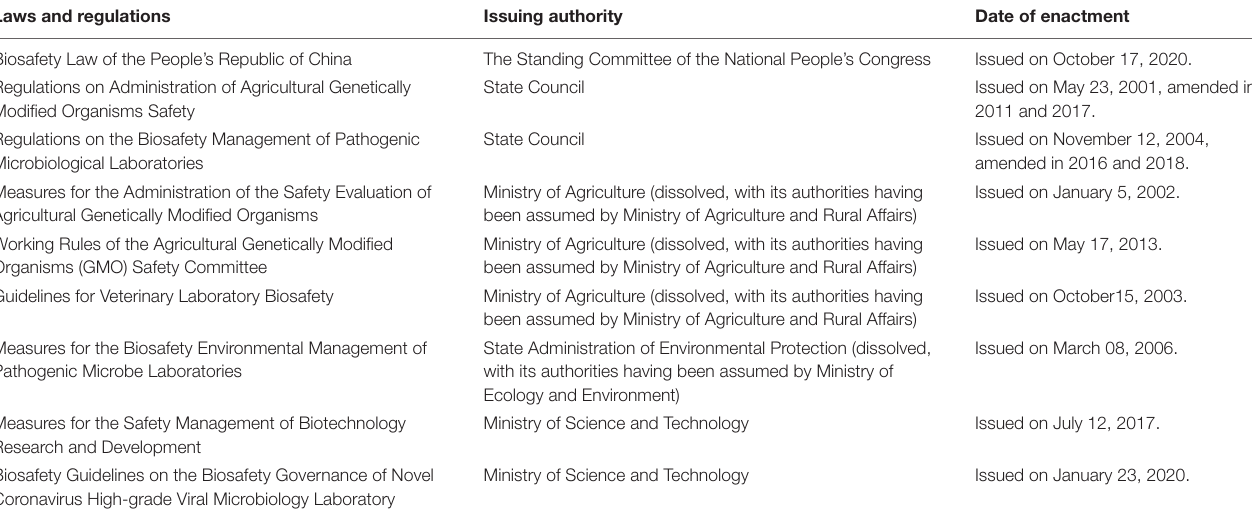
TABLE 1 | List of the regulations on biosafety governance of synthetic